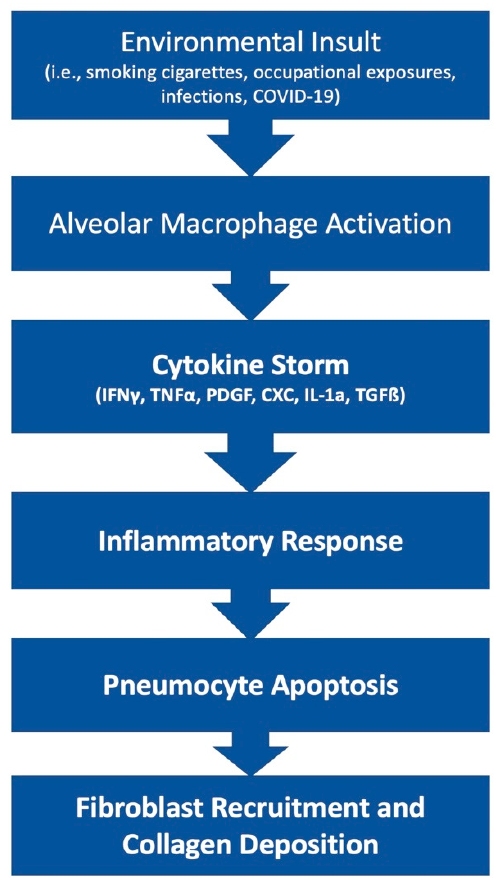
Figure 1. Simplified diagram of the development of fibrosis.